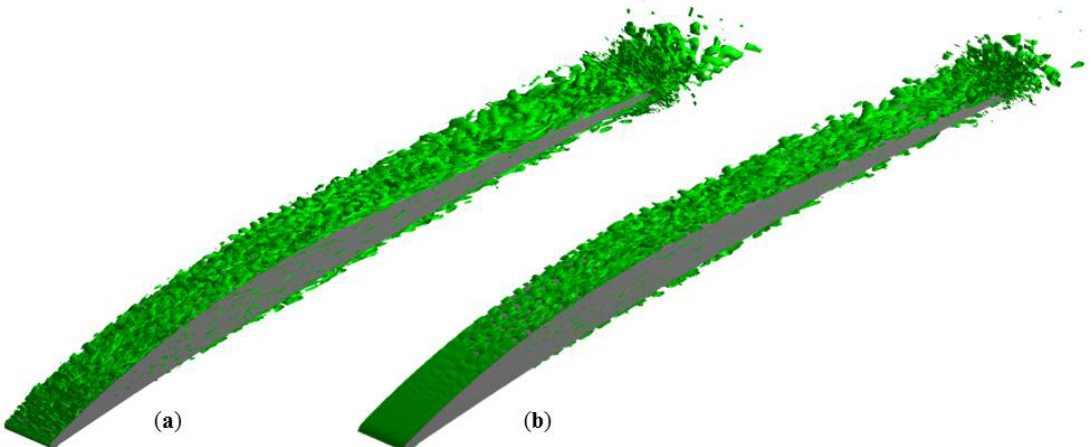
Figure 22. Iso-surface of the Q-criterion on the suction side: ( a ) circular LE; ( b ) continuous-curvature LE.